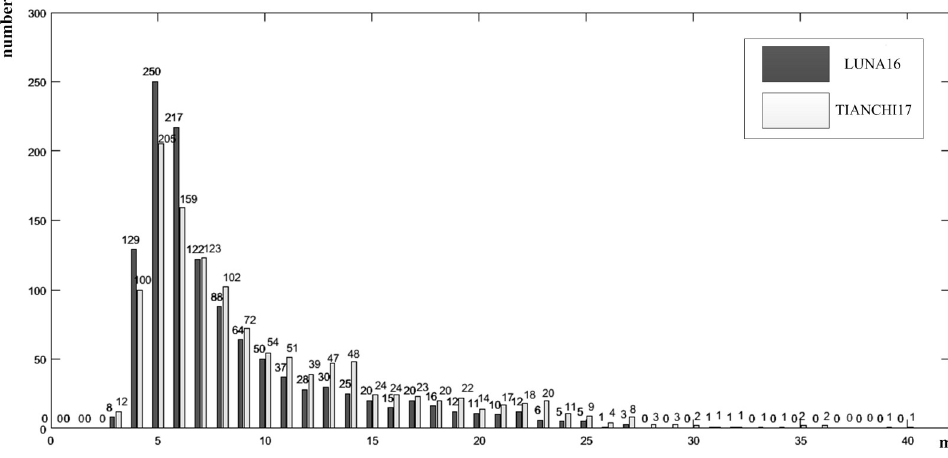
Fig 11. Pulmonary nodules distribution of radius in CT images with diameter of 3–30